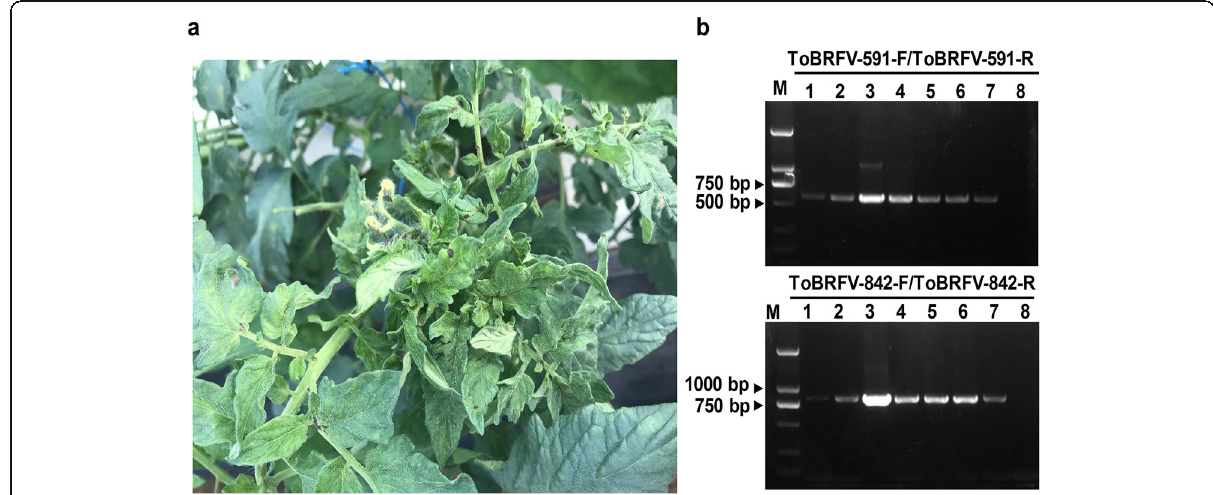
Fig. 1 Detection of tomato brown rugose fruit virus (ToBRFV) from diseased tomato plants. a Symptoms observed on ToBRFV-infected tomato plants in Yunnan Province of China. b Detection of ToBRFV by RT-PCR with two sets of ToBRFV-specific primers. Lane M, DL2000 DNA marker (TaKaRa). Lanes 1 – 7 indicate PCR products amplified from seven samples (Y2020 – 1, Y2020 – 2, Y2020 – 3, Y2020 – 4, Y2020 – 5, Y2020 – 6, and Y2020 – 7), respectively. Lane 8, double distilled water (ddH 2 O) was used as the negative